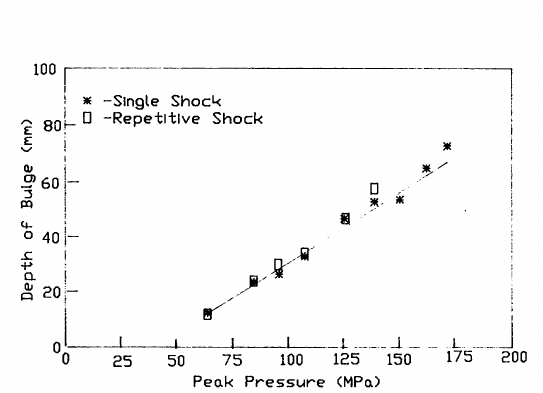
FIGURE 8 Dependence of depth of bulge on peak pressure for single and repetitive